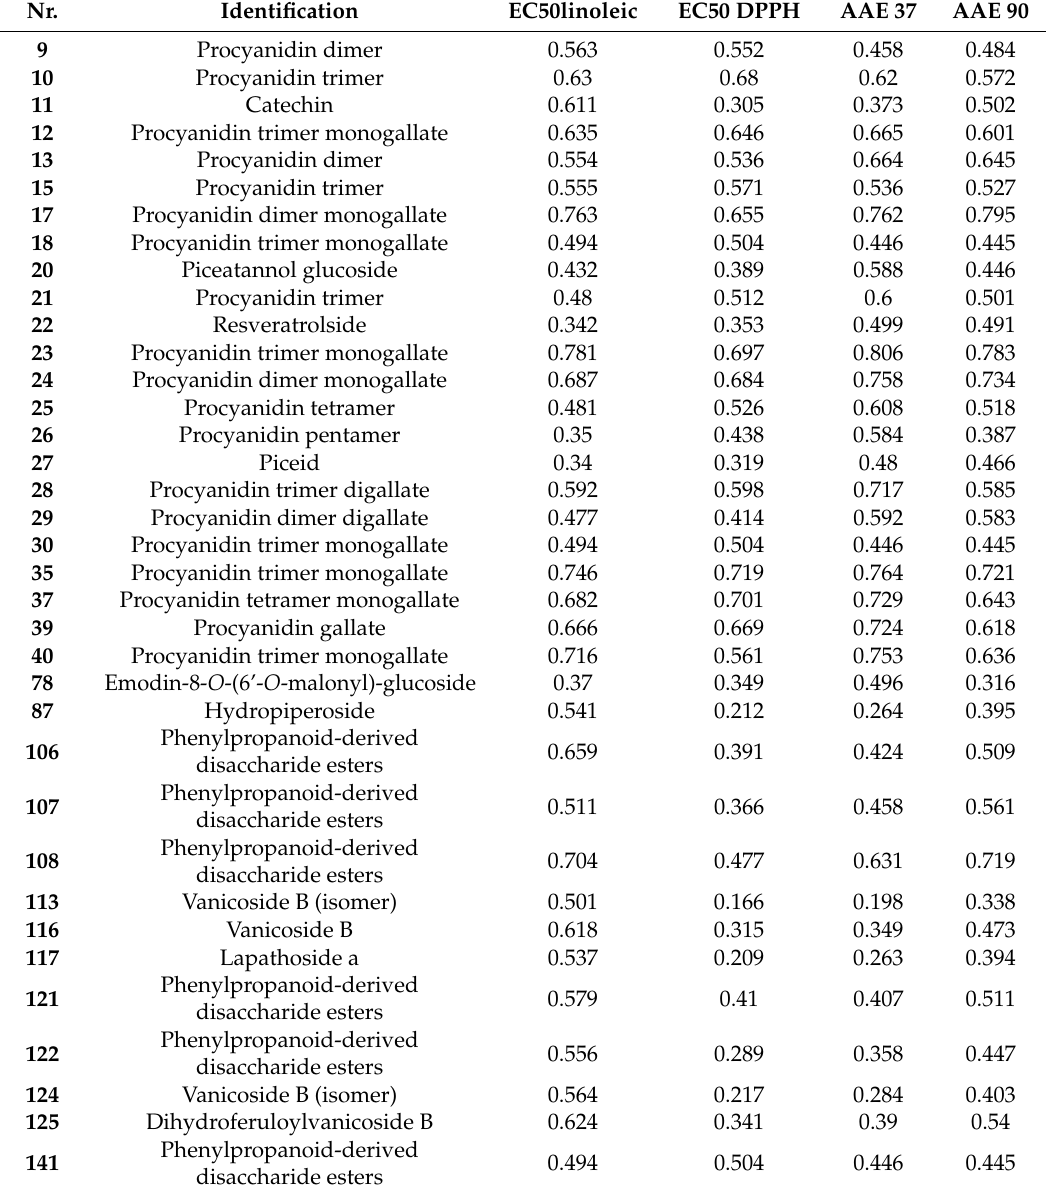
Table 5. Correlation between the peak area of detected compounds (established by using mass spectral deconvolution) and activity of extracts/fractions (1/EC 50 DPPH, Reducing power AAE 37, 90 (%), 1/EC 50 of LA peroxidation) was described with the statistical methods-correlation matrix. In the table are presents only peaks with positive correlation, significant at p <